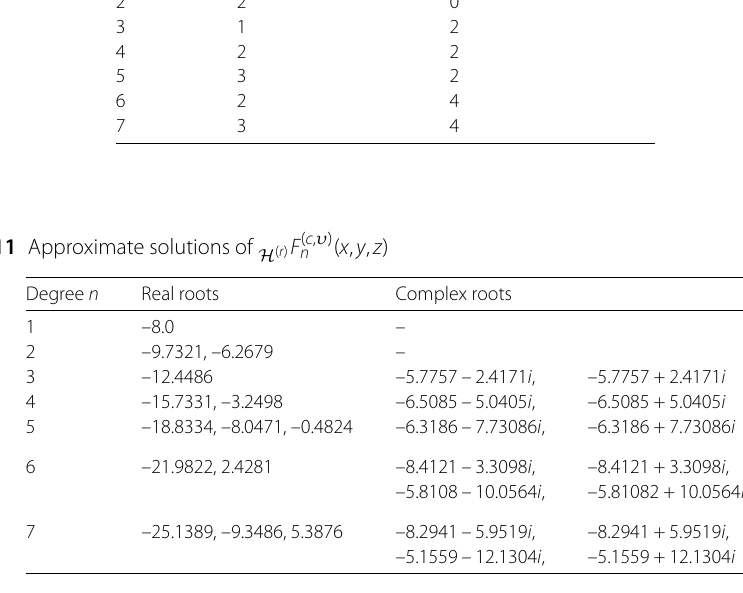
Table 10 Numbers of real and complex zeros of